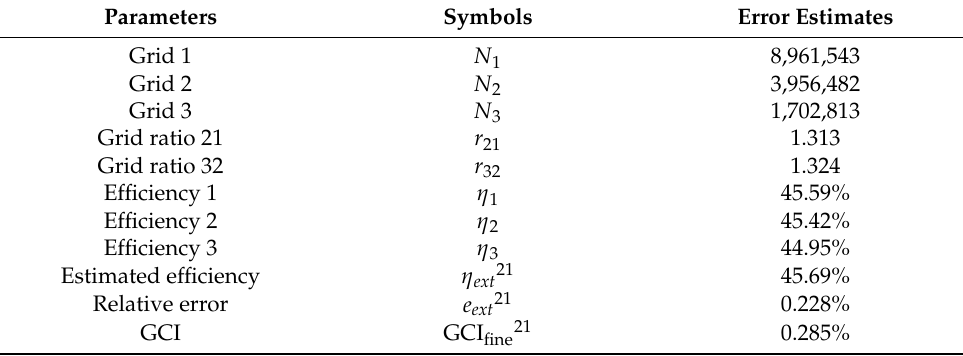
Table 2. Evaluation of grid error.